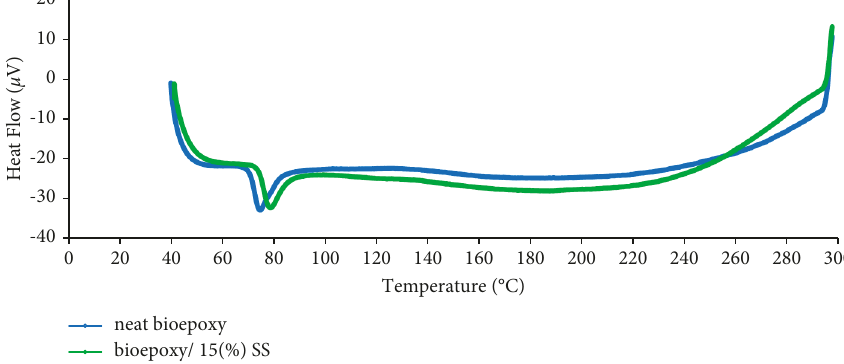
Figure 9: DSC curves for pristine bioepoxy and bioepoxy/15wt% SS